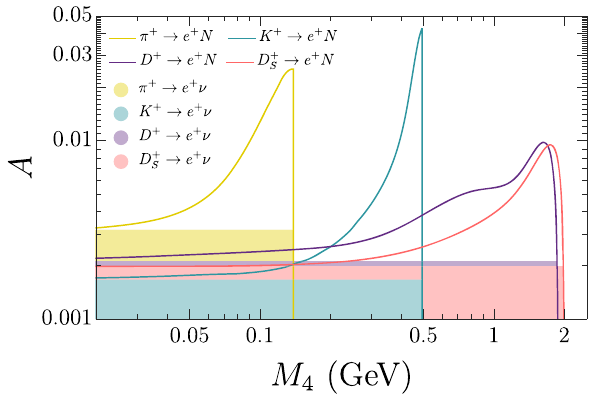
Fig. 4 Total detector acceptance as a function of the heavy neutrino mass. For reference, the total acceptance of the detector in the light neutrinocaseisindicatedbytheshadedregions:3 . 2 × 10 − 3 forneutrinos produced from pion decays, 1 . 7 × 10 − 3 for neutrinos from kaon decays, 2 . 1 × 10 − 3 for neutrinos from D decays, and 2 . 0 × 10 − 3 for